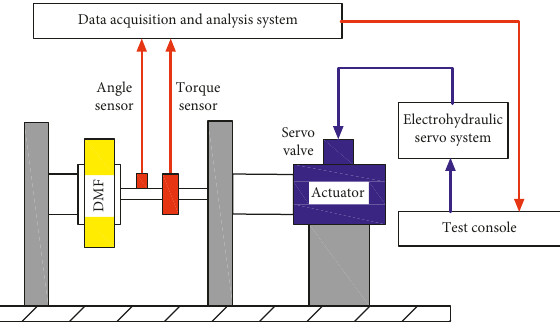
Figure 8: Structure diagram of the test bench.